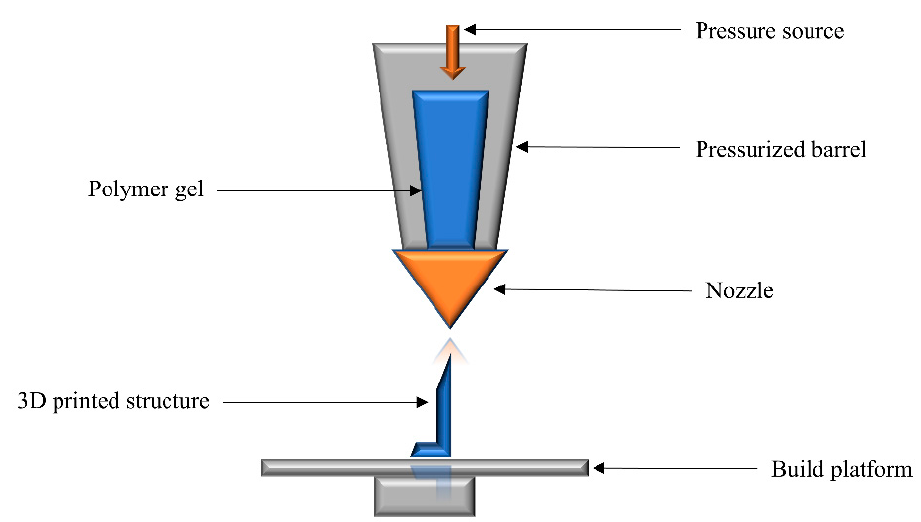
Figure 3. Schematic diagram of the direct ink writing (DIW) process. Redrawn from [10].